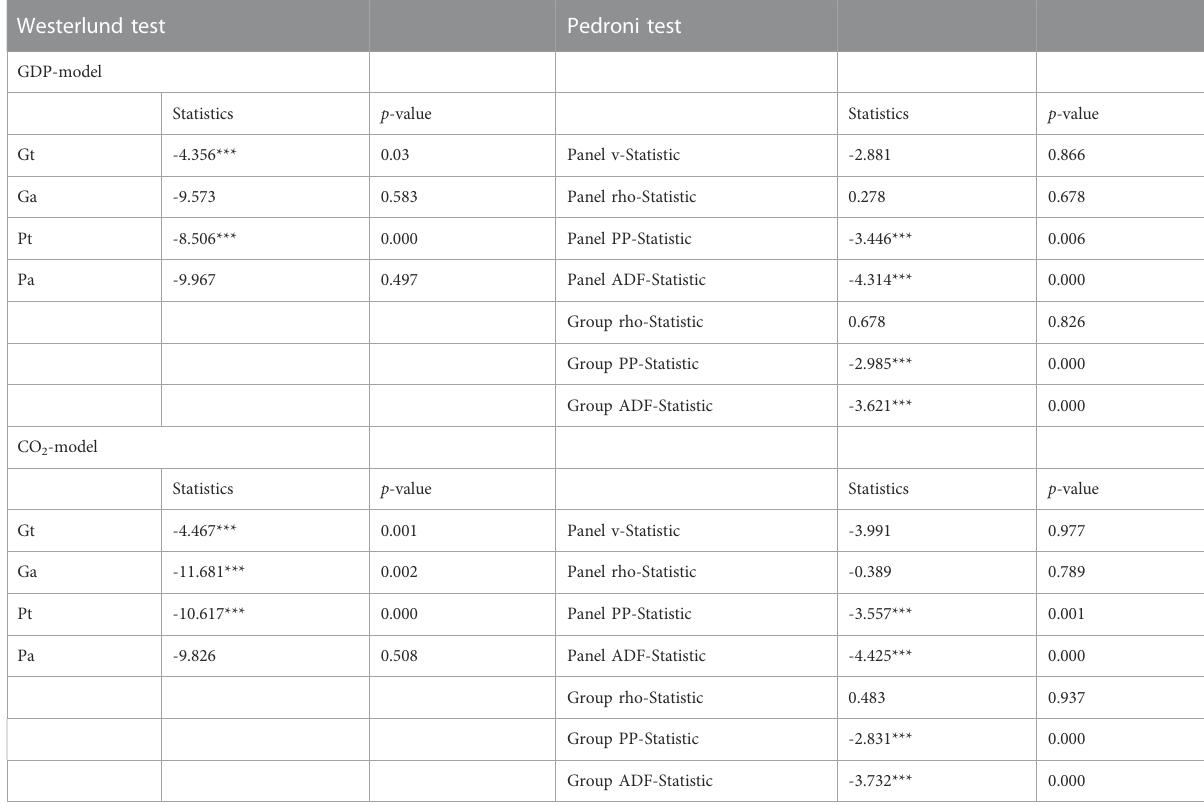
TABLE 5 Results of Westerlund (2007) and Pedroni (1999) Panel Cointegration tests. Westerlund